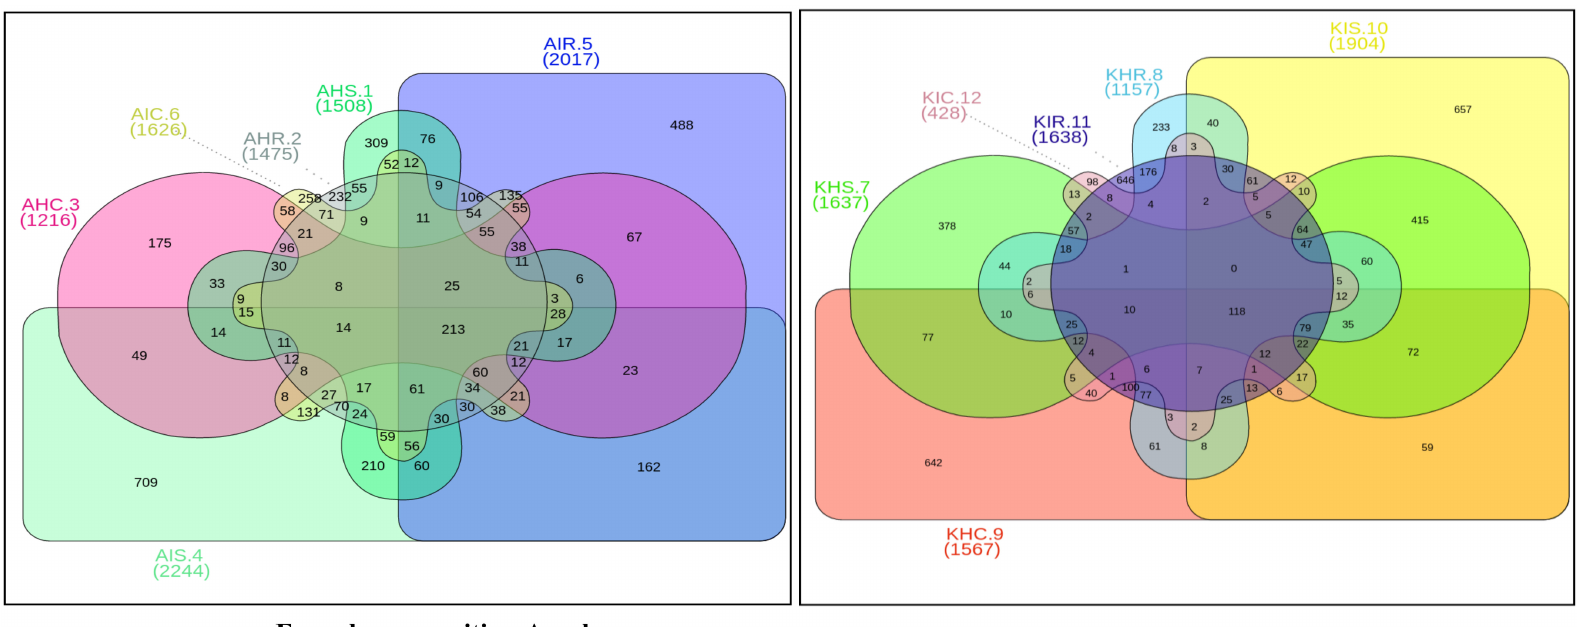
Figure 4. Venn diagram of the banana rhizosphere, roots, and corm. The observed OTUs for each treatment were produced in the UCLUST algorithm to show the shared and unique OTUs. Only the most abundant OTUs among all the samples were represented. A: Arusha; C: Corm; H: Asymptomatic; I: Symptomatic; K: Kilimanjaro; R: Roots; S: